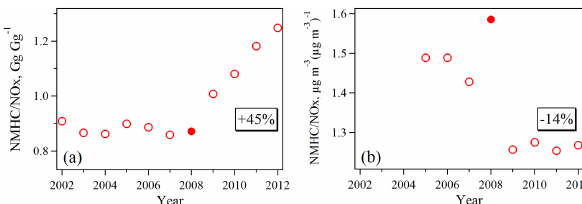
Figure 11. Temporal changes in (a) emission ratios of NMHCs to NO x (MgMg − 1 ) from 2002 to 2012 in Beijing reported by the MEIC inventory and (b) concentration ratios of NMHCs to NO x (µgm − 3 (µgm − 3 ) − 1 ) obtained by ambient measurements during August at the PKU site from 2005 to